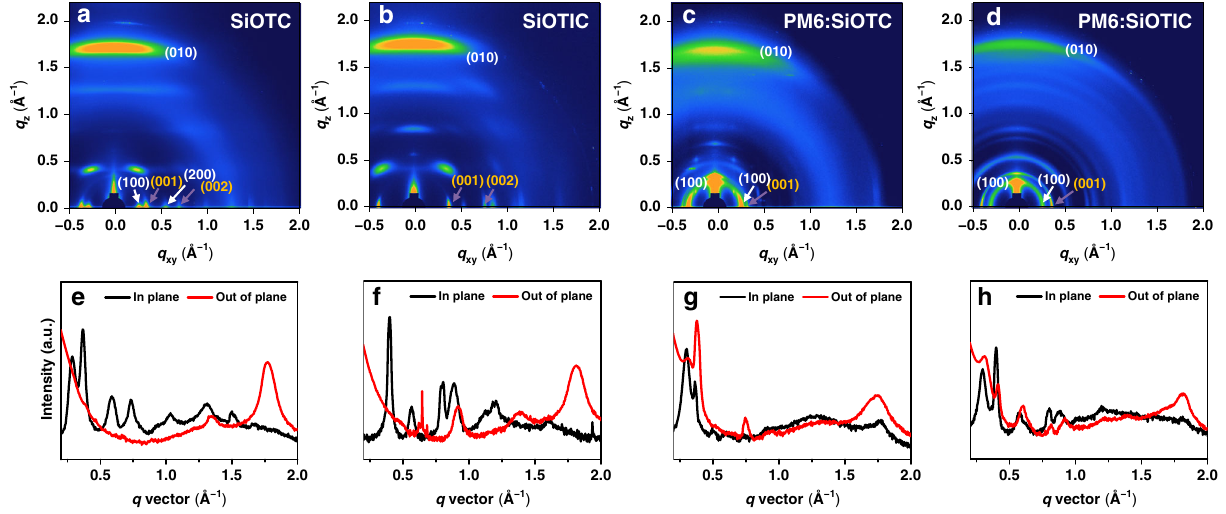
Fig. 7 GIWAXS results. a GIWAXS pattern of the SiOTC fi lm. b GIWAXS pattern of the SiOTIC fi lm. c GIWAXS pattern of the PM6:SiOTC blend fi lm. d GIWAXS pattern of the PM6:SiOTIC fi lm. e The line-cuts of in-plane and out-of-plane SiOTC . f The line-cuts of in-plane and out-of-plane SiOTIC . g Line cuts of the in-plane and out-of-plane PM6:SiOTC blend fi lms. h Line cuts of the in-plane and out-of-plane PM6:SiOTIC blend fi